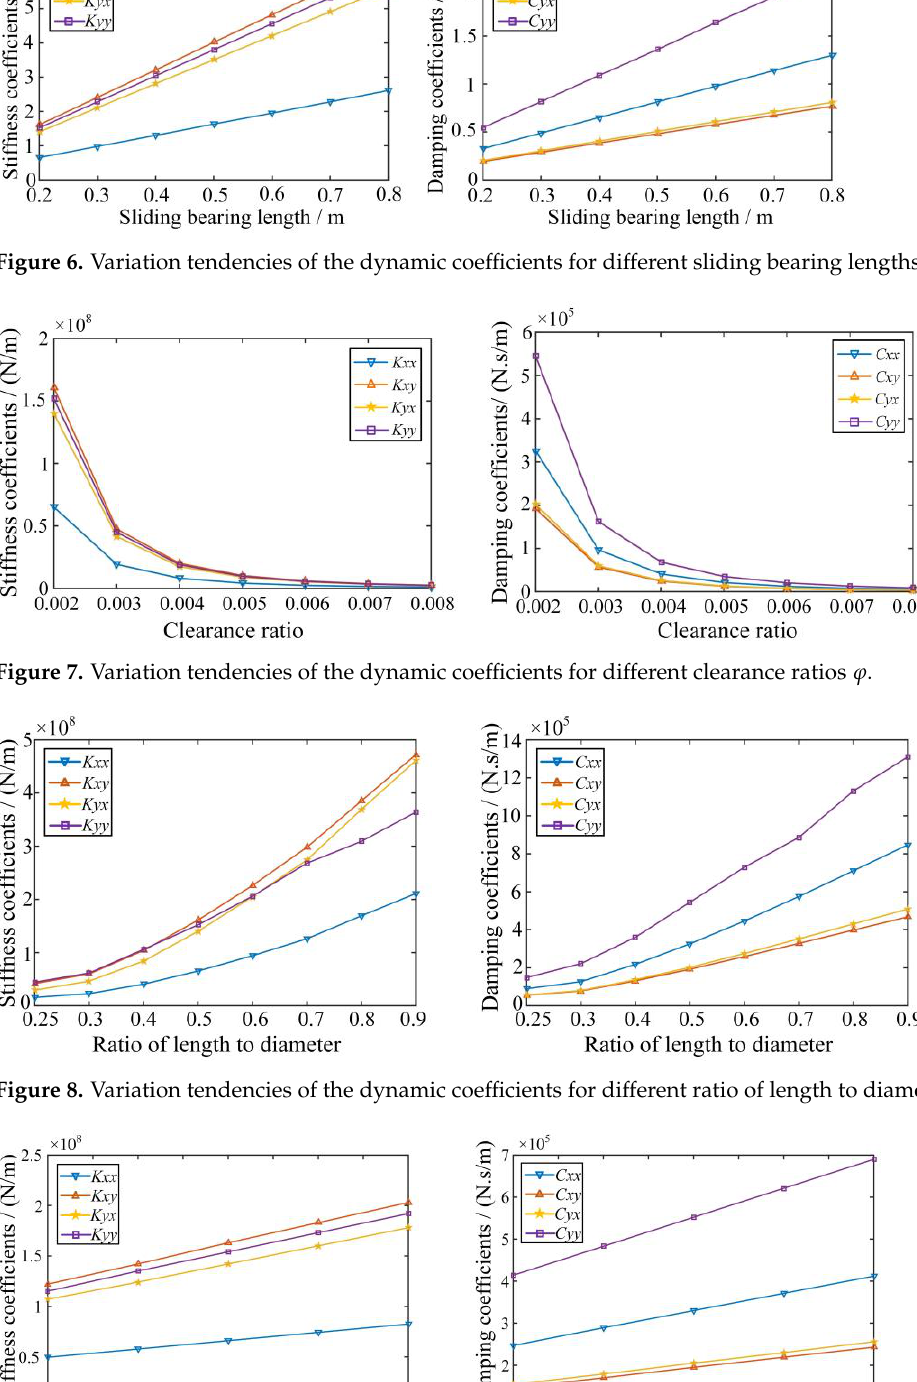
Figure 9. Variation tendencies of the dynamic coefficients for different viscosity coefficients η .